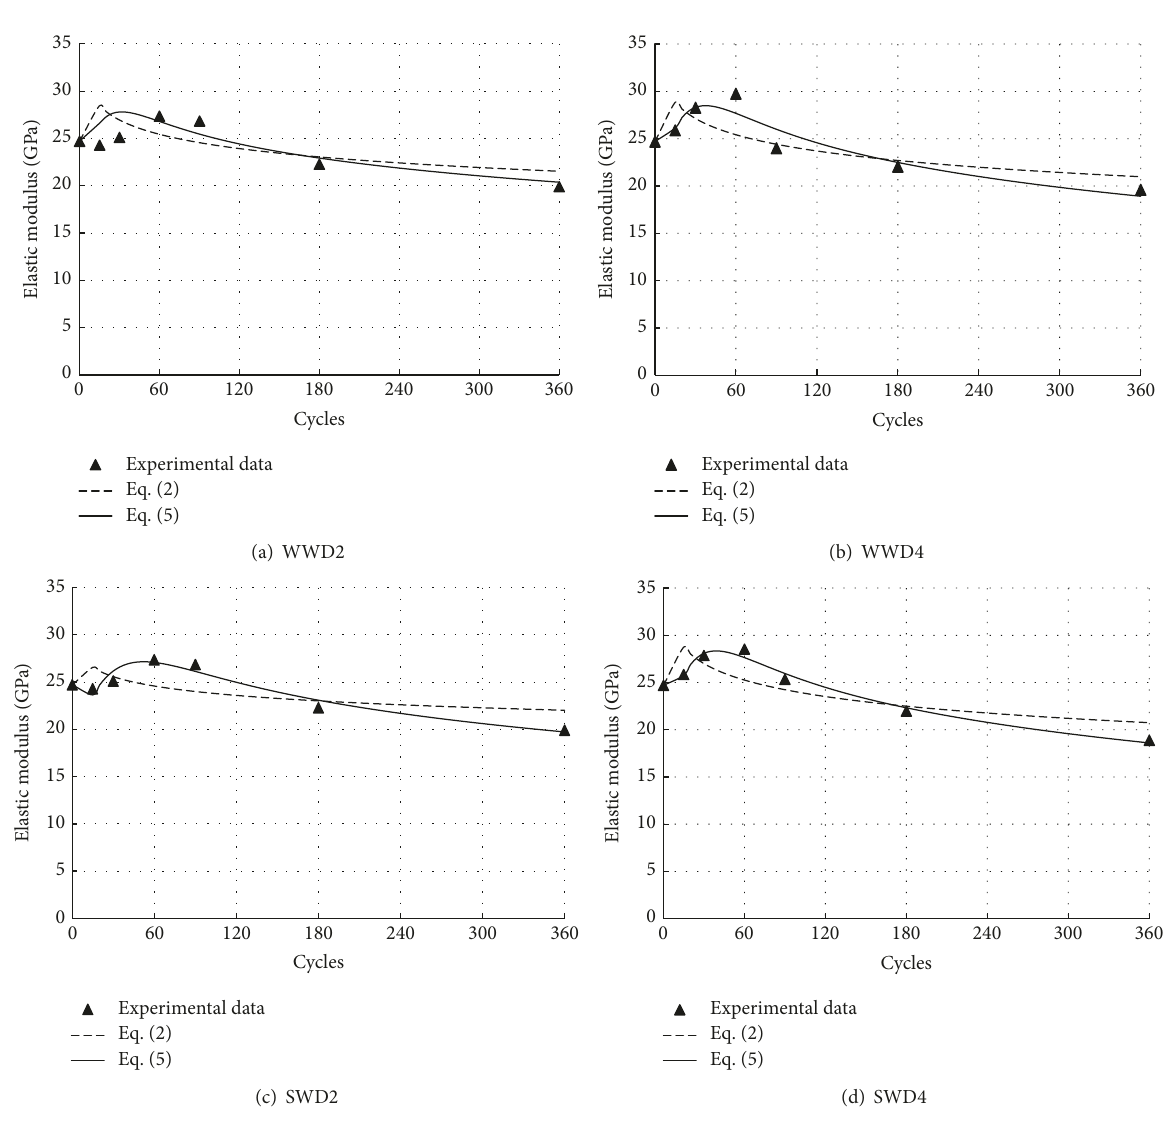
Figure 12: Comparison of prediction of elastic